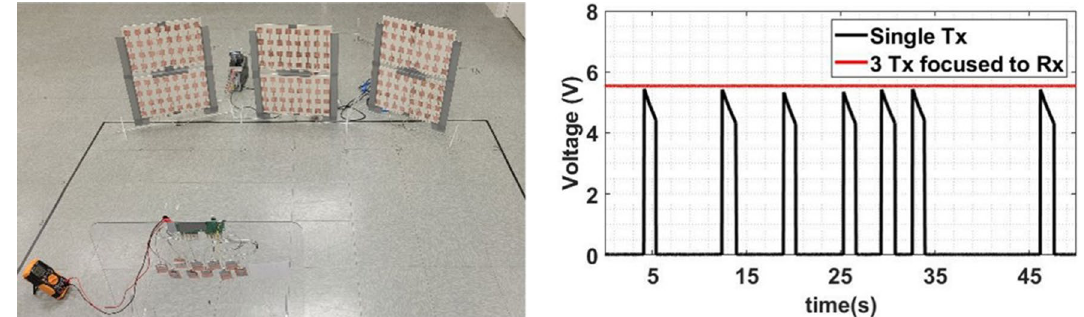
Figure 10. Duty cycle comparison from the power management unit for single Tx versus beam-steered multiple Tx scenarios. Plot generated using Matlab R2019b available at https:// mathw orks. com. Distance Tx-Rx